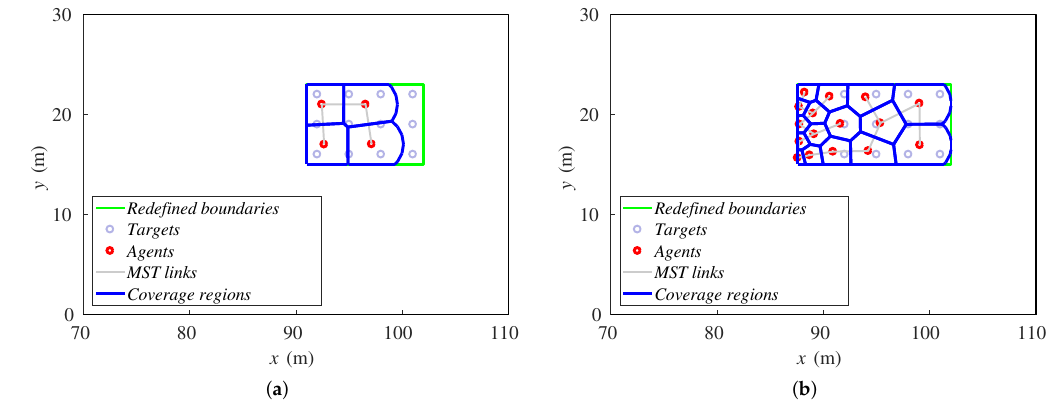
Figure 12. Final positions of agents and targets for ( a ) four robots and ( b ) 16